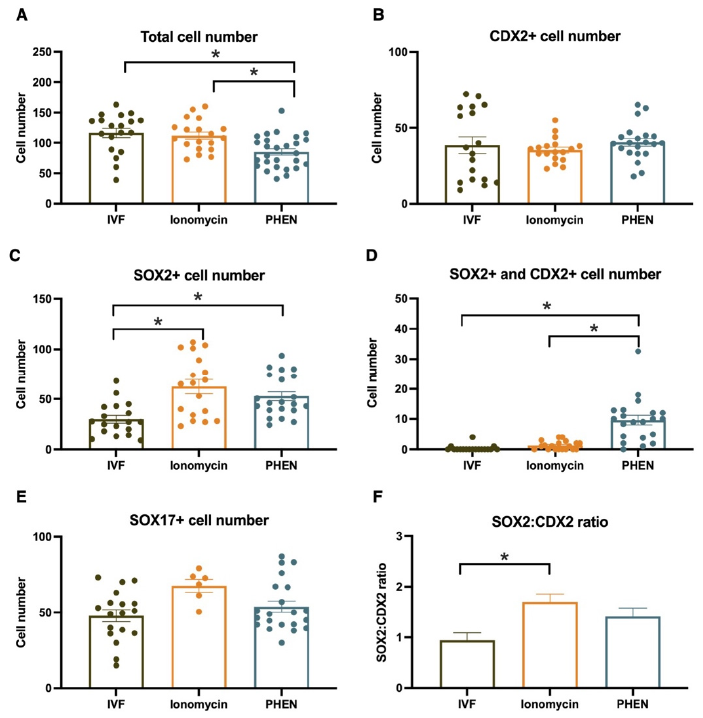
Figure 2. Analysis of cell number and expression of transcription factors of bovine blastocyst from different experimental groups. Blastocysts from three biological replicates were analyzed; 15 to 27 embryos/group; * p < 0.05, Kruskal-Wallis test. IVF, in vitro fertilization; PHEN, 1,10-phenanthroline.